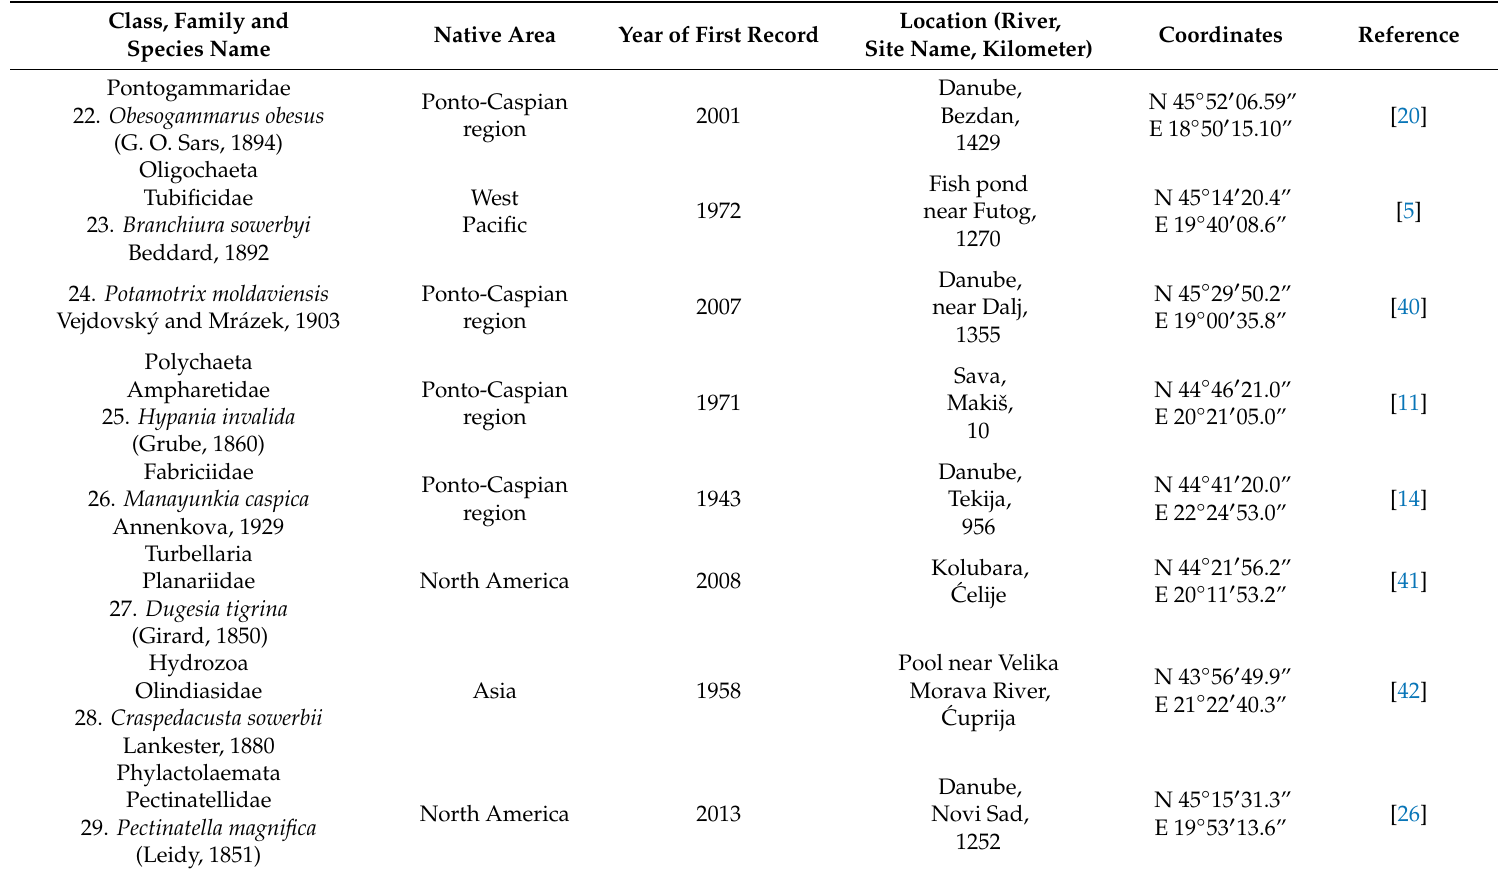
Table 3. Allochthonous macroinvertebrate species in watercourses of Serbia. (JDS 3—Joint Danube Survey 3). Class, Family